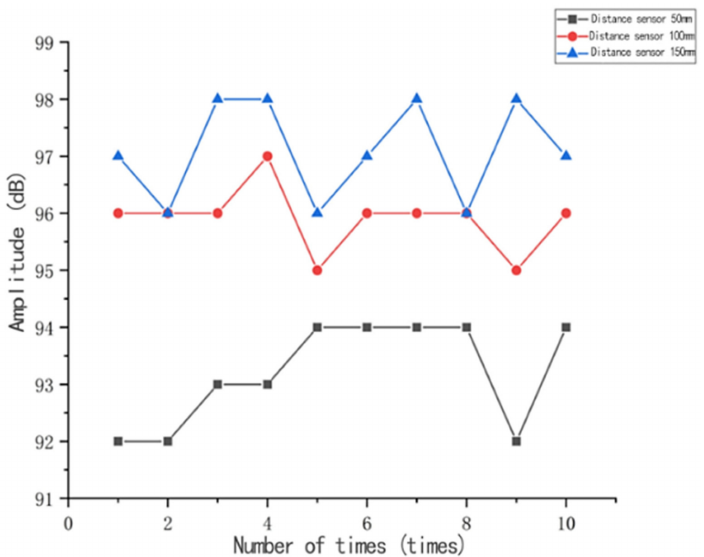
Figure 3. Graph of the results of the lead break test.